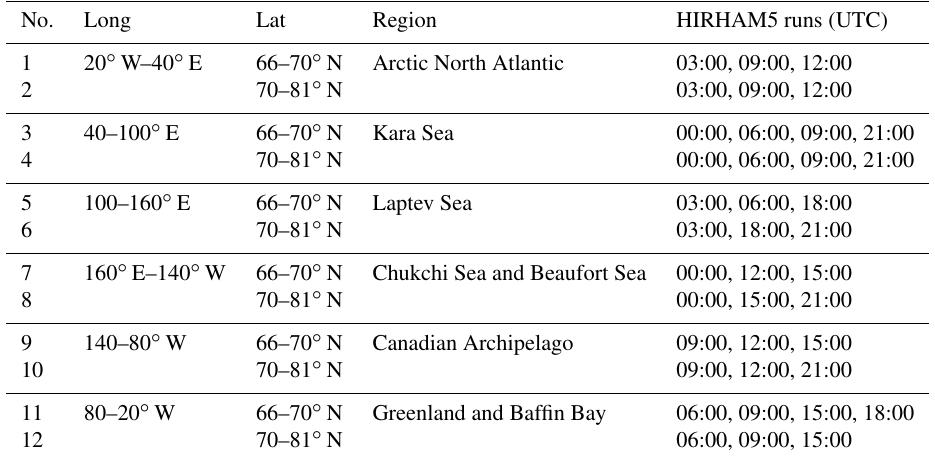
Table 1. The studied 12 regions divided equally in longitude with 60 ◦ to have the same sampling size between the different regions and in latitude divided into two latitude rings to examine the southern and northern parts of the Arctic separately. The last column shows statistically coinciding HIRHAM5 model run times with the CloudSat overpasses. No.